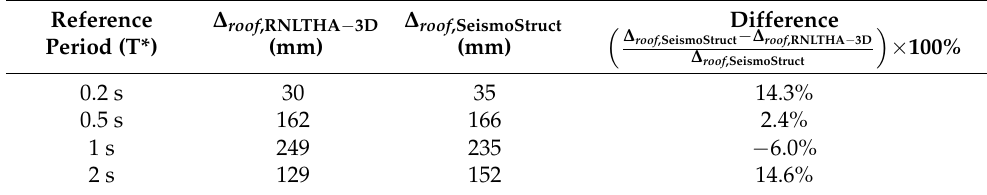
Figure 9. Comparison of the maximum displacement profile of each of the four reference periods obtained using Routine 2 (RNLTHA-3D) and SeismoStruct. Table 1. Comparison of maximum 3D roof displacement obtained from the proposed RNLTHA-3D and SeismoStruct.